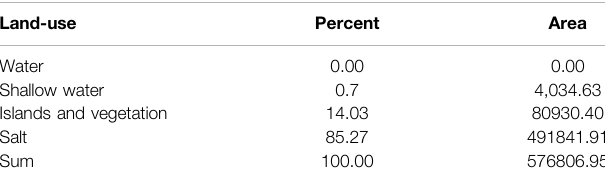
TABLE 3 | Simulation land-use change until